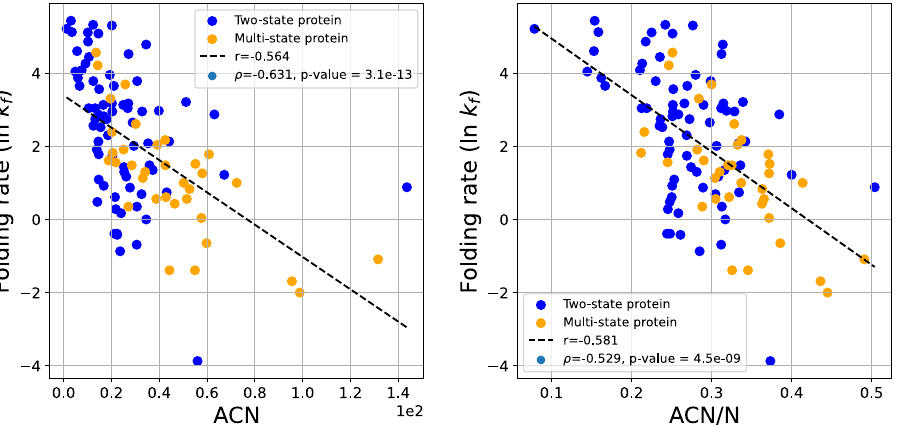
Figure 5. The folding rate as a function of the native state ACN (left) and the ACN/N (right) for all proteins. Multi-state proteins tend to have higher ACN than two-state proteins with similar folding rates.